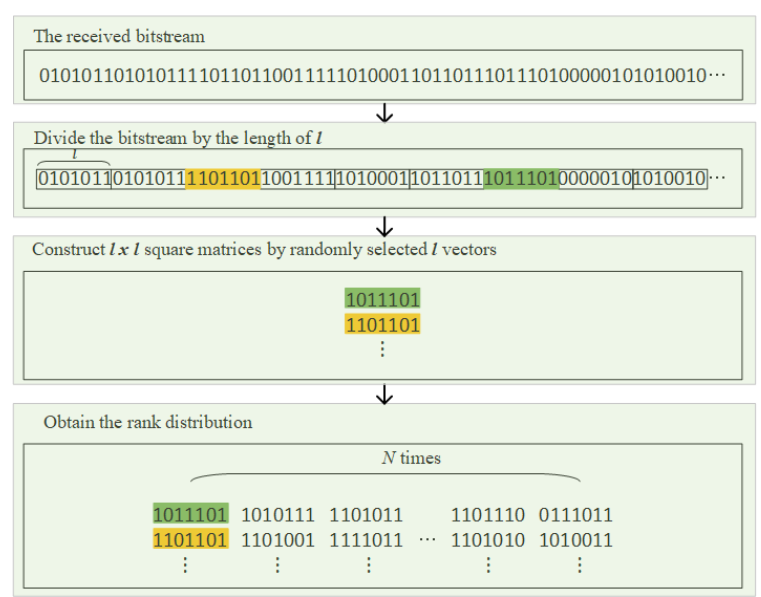
Figure 4. Processes used to obtain the rank distribution from the received